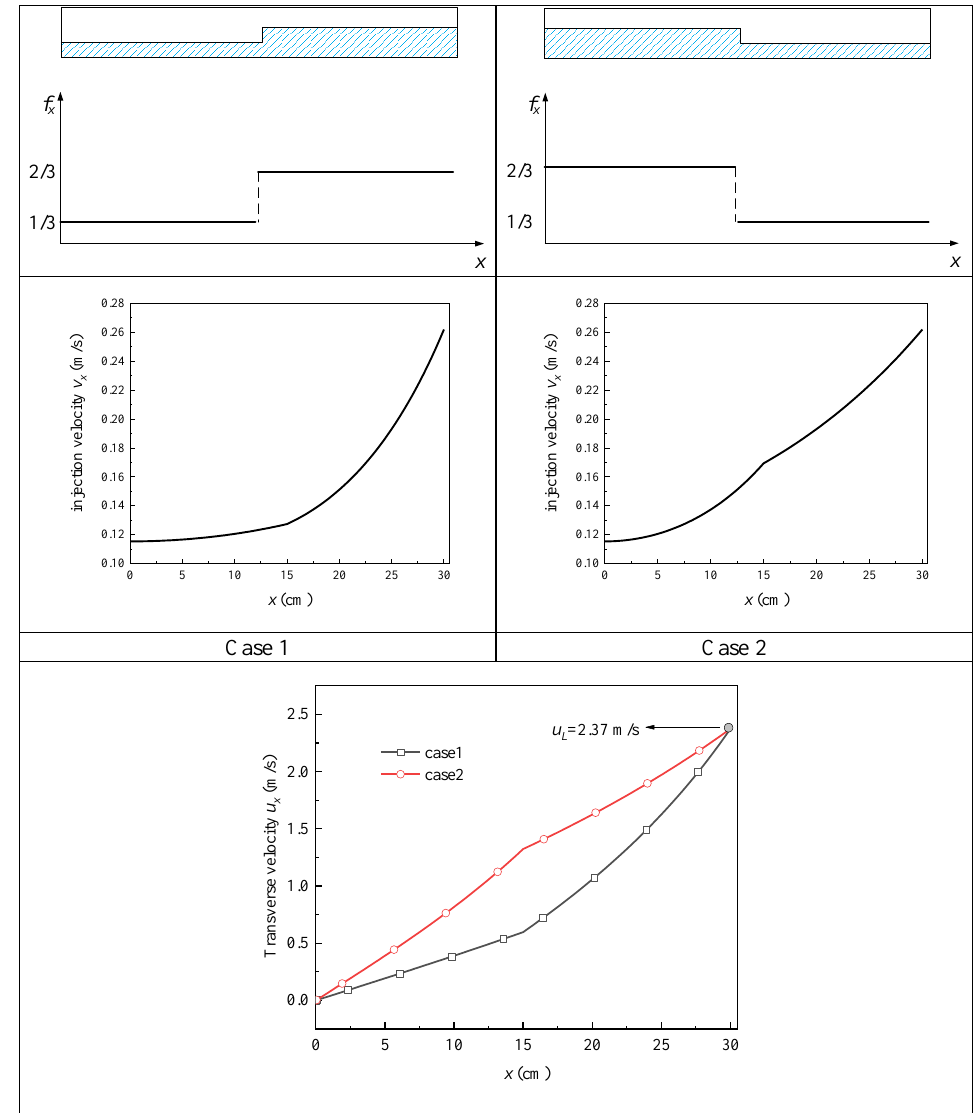
Figure 8. Comparison of cases with two bubbles at different positions.